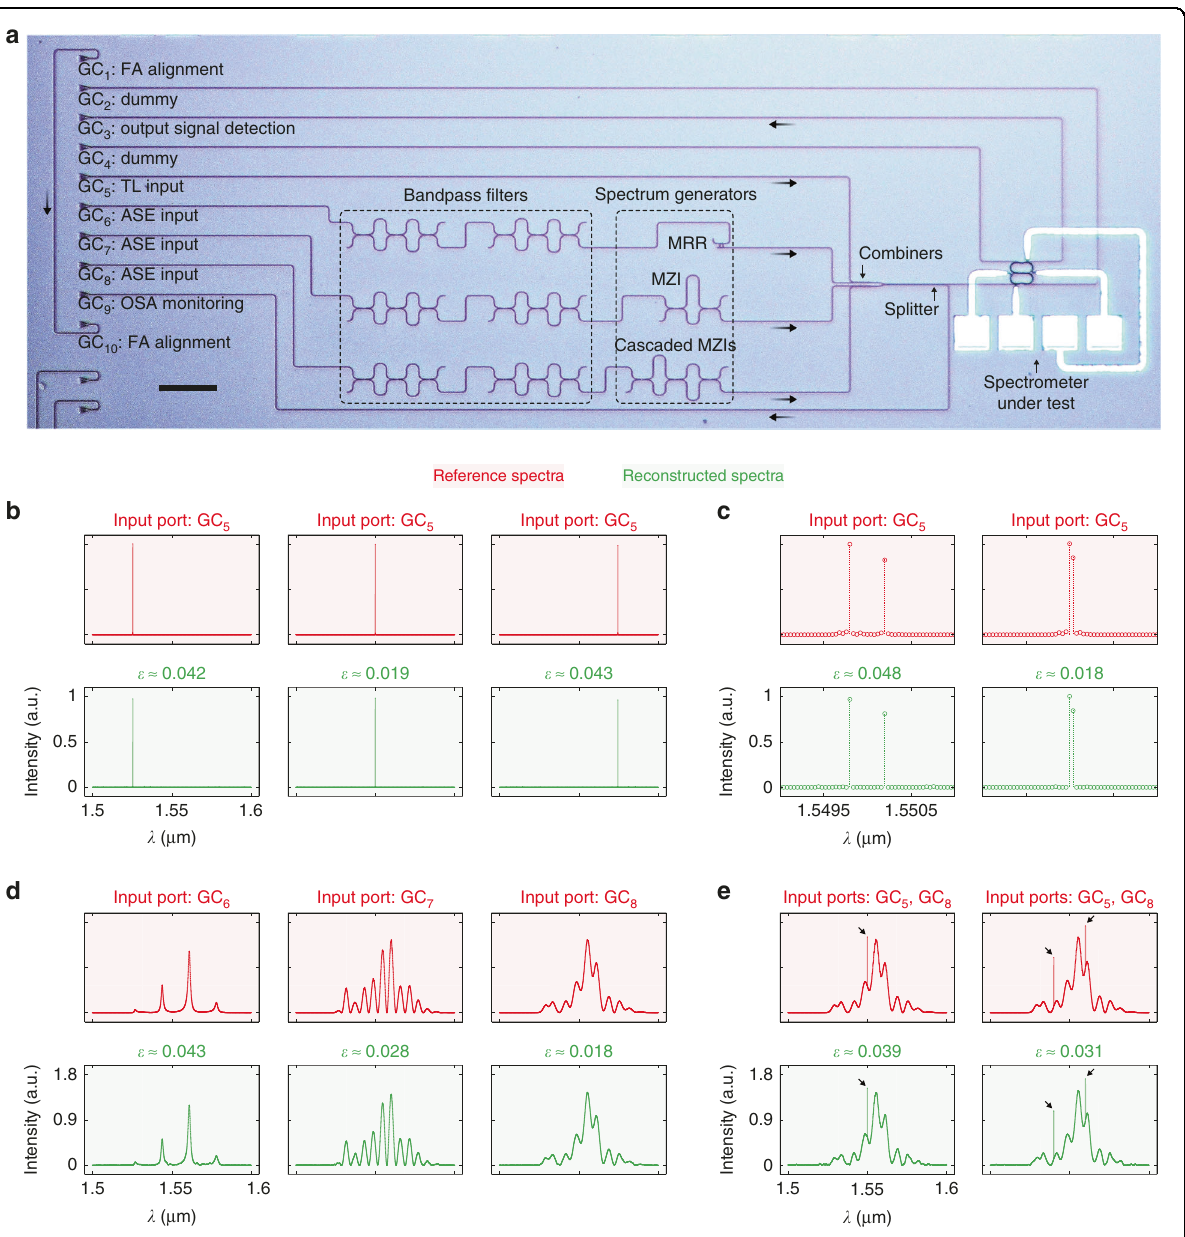
Fig. 7 Experimental reconstruction of spectra. a Microscope image of the fabricated monolithic measurement system with all the on-chip components labeled. The scale bar represents 100 μ m. Reconstruction results for b single spectral lines, c dual spectral lines, d continuous spectra, and e hybrid spectra with relative errors ( ε ) and used input ports labeled. Here, reference and reconstructed spectra are displayed in red and green, respectively. For clarity, dual spectral lines are displayed with zoom-in views. GC grating coupler, MRR micro-ring resonator, MZI Mach-Zehnder interferometer, TL tunable laser, ASE ampli fi ed spontaneous emission source, OSA optical spectrum analyzer, FA fi ber